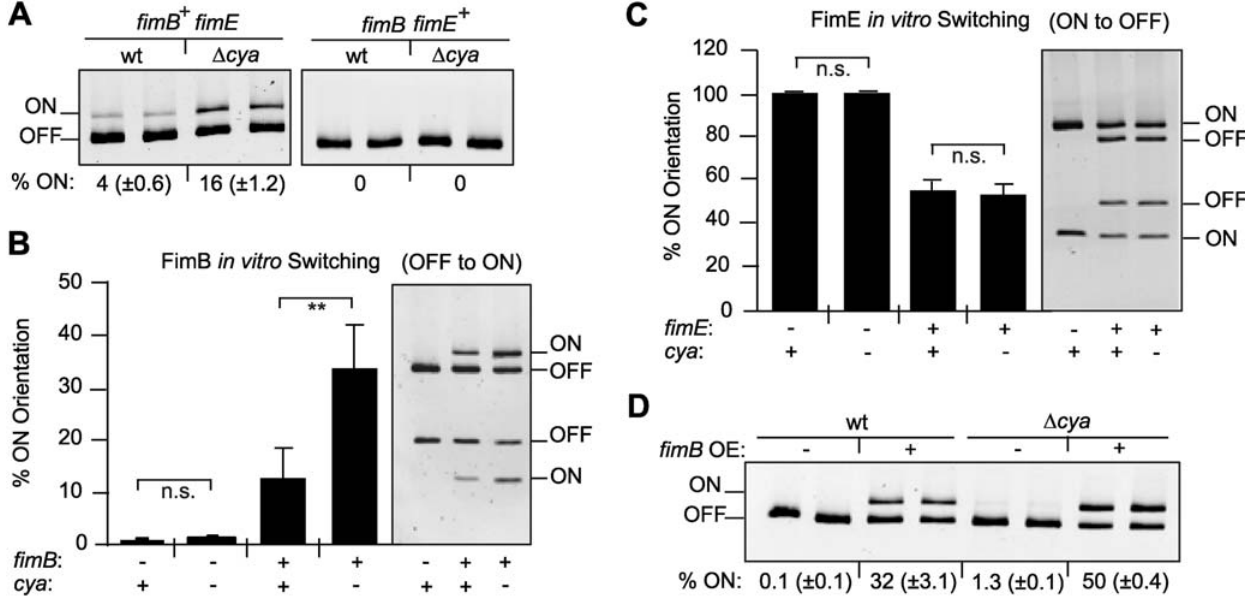
Figure 4. The CRP-cAMP regulatory complex affects the FimB-mediated OFF to ON switch. (A) Determination of the percentage of ON- cells in strains expressing either FimB (AAEC370A, fimB + fimE ) or FimE (AAEC261A, fimB fimE + ) and their cya counterparts. The upper half of a representative gel used for ON-OFF diagnostic is shown. The estimated percentage of ON-cells in the cultures (% ON) is indicated as mean values and standard deviations in brackets of three independent experiments. (B) In vitro OFF to ON recombination assay in bacterial extracts either containing FimB or being recombinase free. Bacterial extracts were obtained from strain NEC026 ( fim , cya + ) and its isogenic cya mutant CMM026, transformed with either an inducible fimB expression plasmid (pIB378, fimB + ) or the vector control (pET11, fimB 2 ). Extracts were mixed with the template plasmid pJL-2 ( fim invertible element in the OFF orientation). The orientation of the plasmid-encoded fim invertible element was determined after 3 h incubation by using the PCR-based assay (see Materials and Methods). Results are provided in the bar diagram as percentage of invertible elements in the ON orientation. The picture in the right part of the Figure illustrates an ethidium bromide stained gel from one of the experiments used to obtain the data shown. (C) In vitro ON to OFF recombination assay in bacterial extracts either containing FimE or being recombinase free. A similar assay as presented in B was performed. In this case, bacterial extracts were obtained from strain NEC026 (wt) or its isogenic cya mutant CMM026, transformed with either an inducible fimE expression plasmid (pIB382, fimE + ) or the vector control (pET11, fimE 2 ). Extracts were mixed with the template plasmid pMM36 ( fim invertible element in the ON orientation) and analyzed as in B. In both B and C, mean values and standard deviations from four independent experiments are shown. (D) Effect of CRP-cAMP deficiency in the percentage of ON-cells in cultures of strain J96 and its cya derivative carrying either the plasmid pPKL9 (constitutive fimB expression, fimB OE + ) or the vector control (pBR322, fimB OE 2 ). The percentage of ON-cells was quantified from cultures of two independent clones. In A and D, the image corresponds to the upper half of an ethidium bromide stained